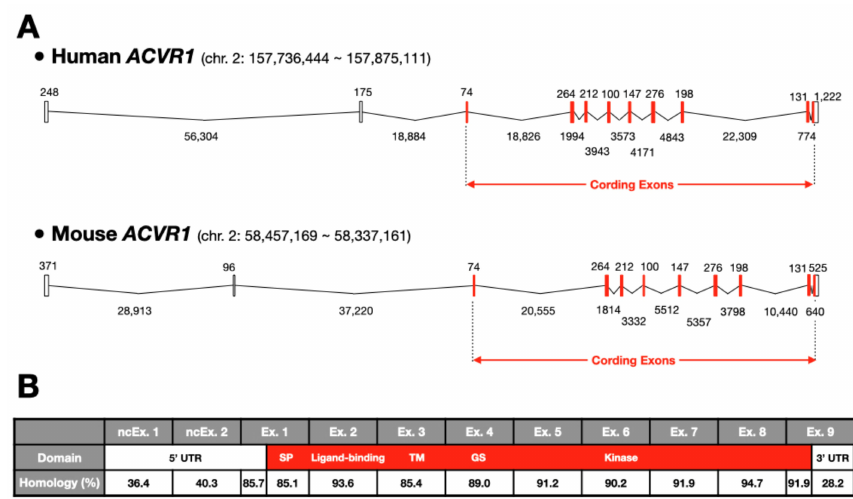
Figure 4. Genomic structures of human and mouse ALK2/ACVR1: ( A ) Genomic structures of humans: ENST00000263640.7 (upper) and mice: ENSMUST00000056376.12 (lower) ALK2/ACVR1 on each chromosome 2 (chr.) are schematically indicated. Open and closed boxes indicate noncoding (nc) and coding exons, respectively. Lines are introns. Numbers are the length of nucleotides. ( B ) Homology of each exon between human and mouse ALK2/ACVR1 genes. Encoded domains are the signal peptide (SP), ligand-binding, transmembrane (TM), glycine/serine domain (GS),